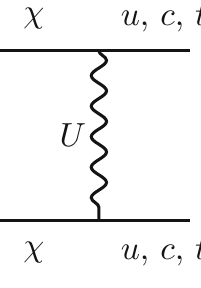
Fig. 1 The Feynman